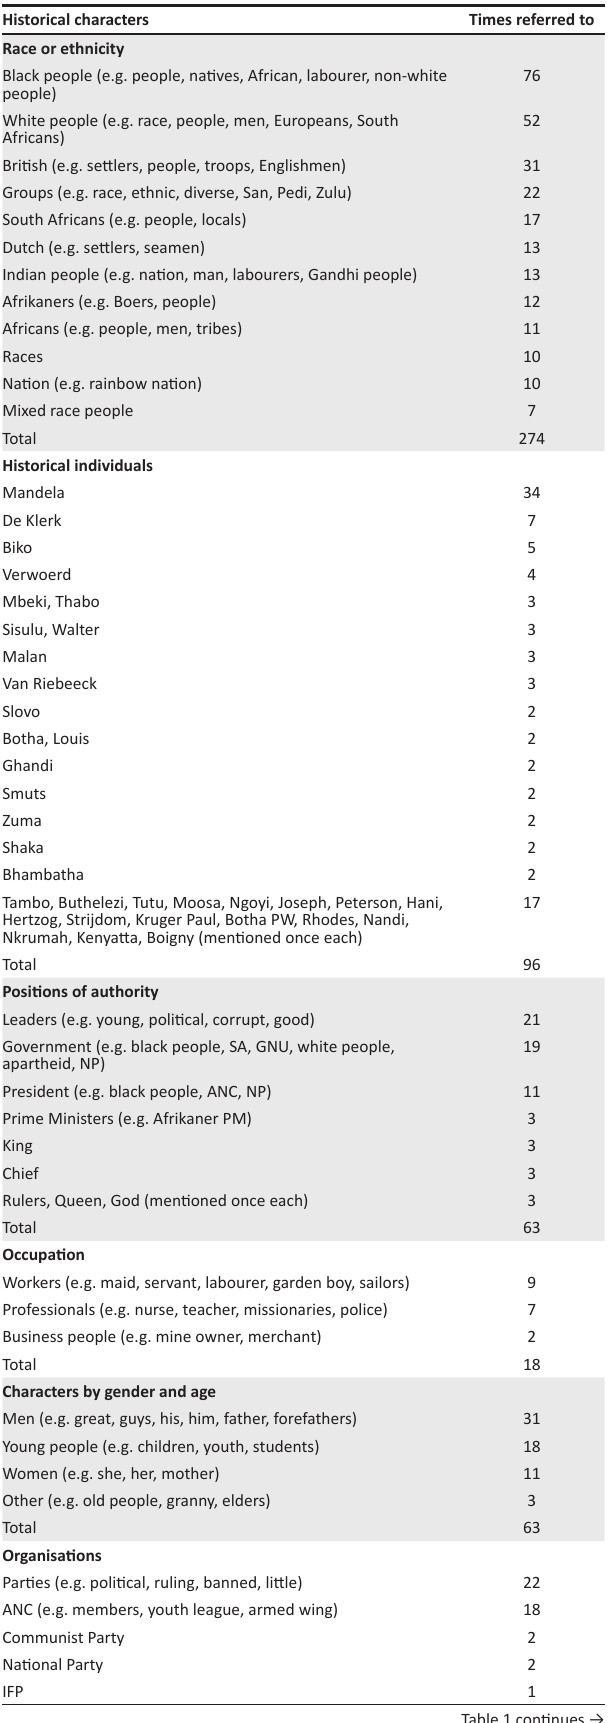
TABLE 1 (Continues...): Historical characters and times referred